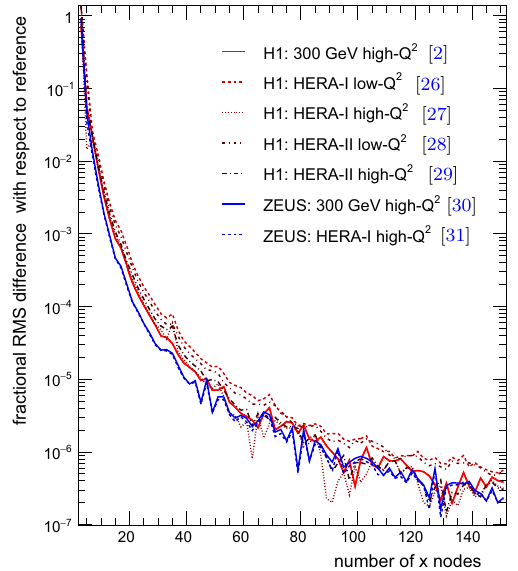
Fig. 1 The RMS difference between the fast grid convolution and ref- erence histogram as a function of the number of grid nodes in momen- tum fraction, x for the HERA inclusive jet measurements in DIS